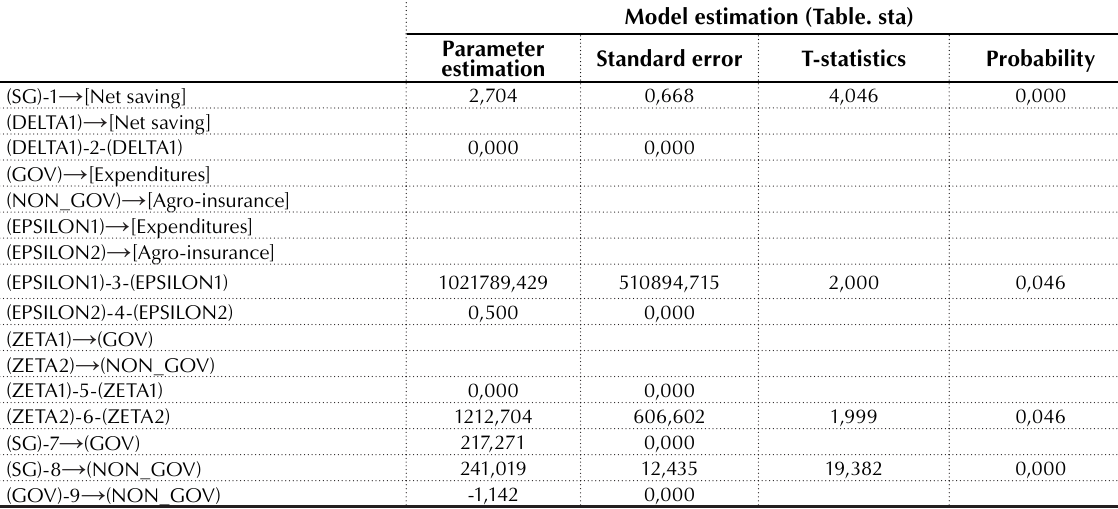
Table 3. Results of structural modeling of the indices relationship for the overall situation in agriculture, state and non-state financing, i.e., agro-insurance Model estimation (Table.